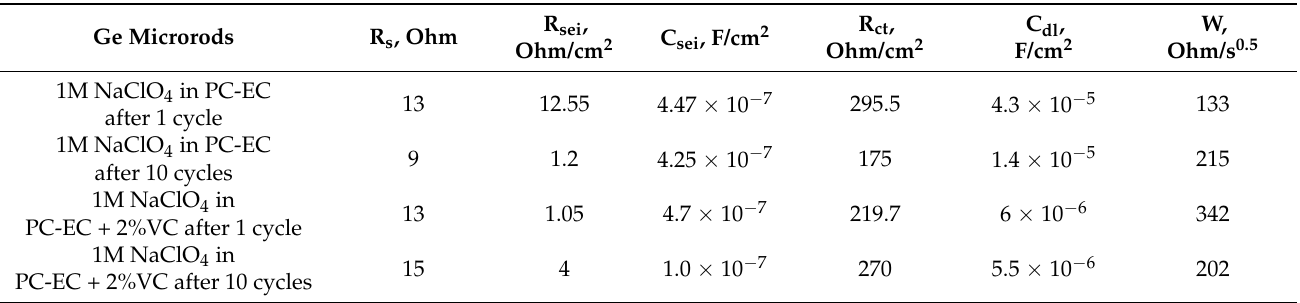
Table 1. The calculated parameters of the equivalent circuit.